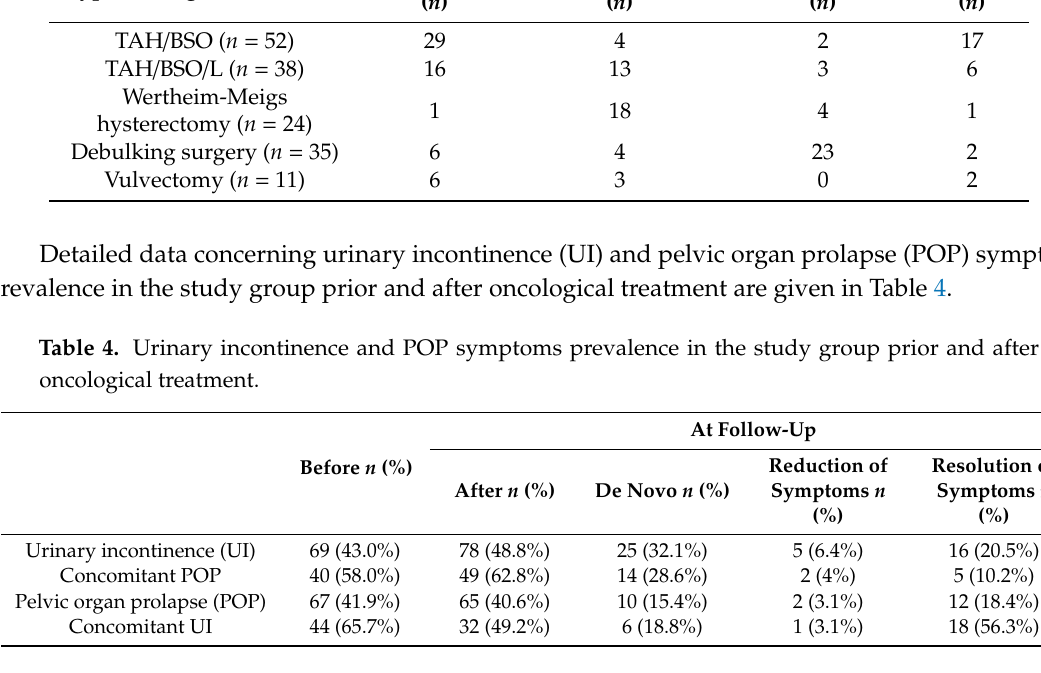
Table 3. Anterograde oncological treatment in study groups. Type of Surgical Treatment